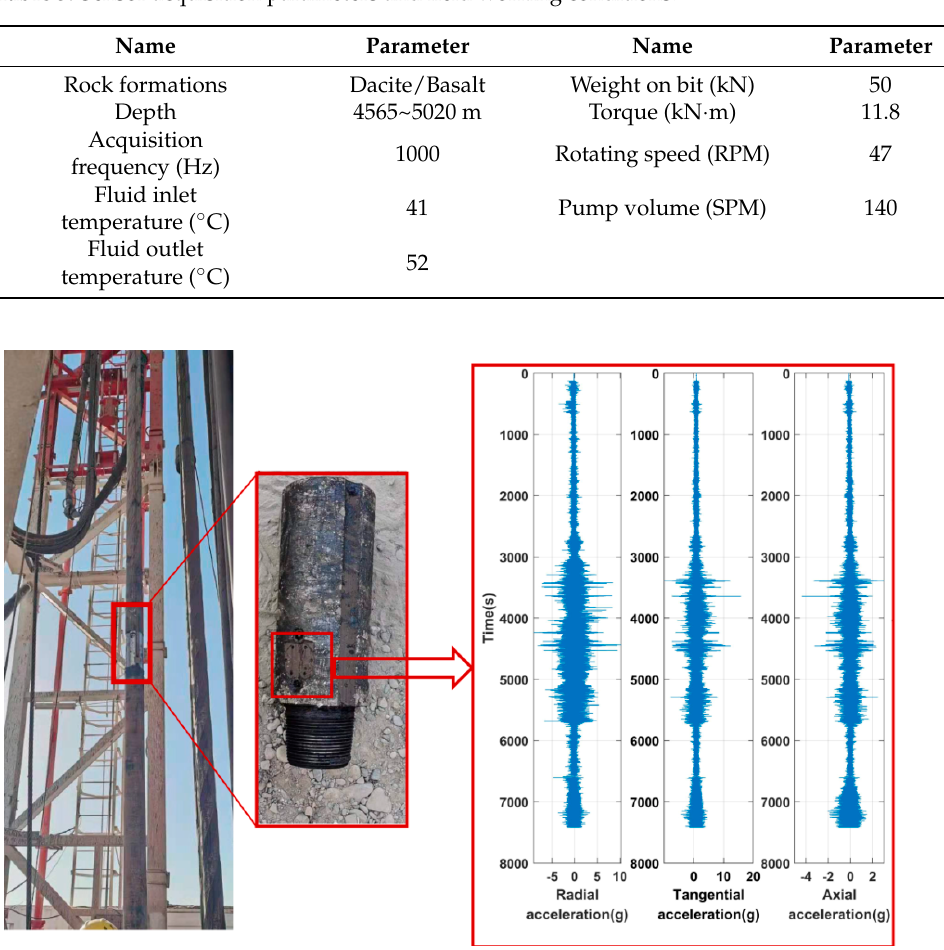
Figure 3. Felid situation of vibration collection